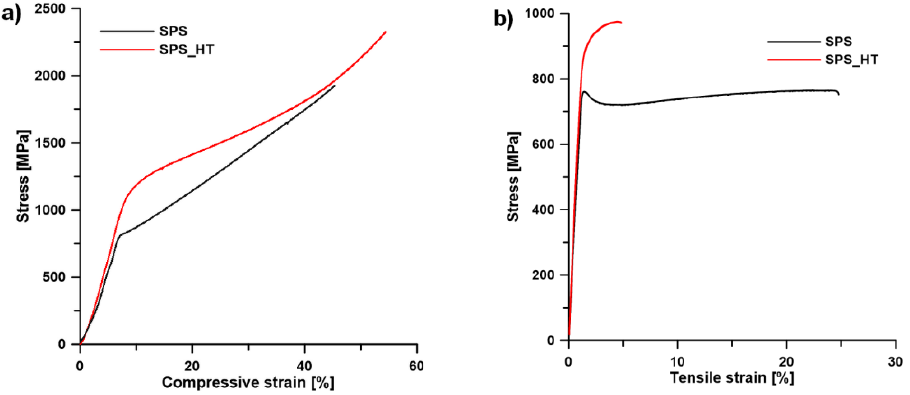
Figure 10. Compressive stress – strain curves ( a ) and tensile stress – strain curves ( b ).